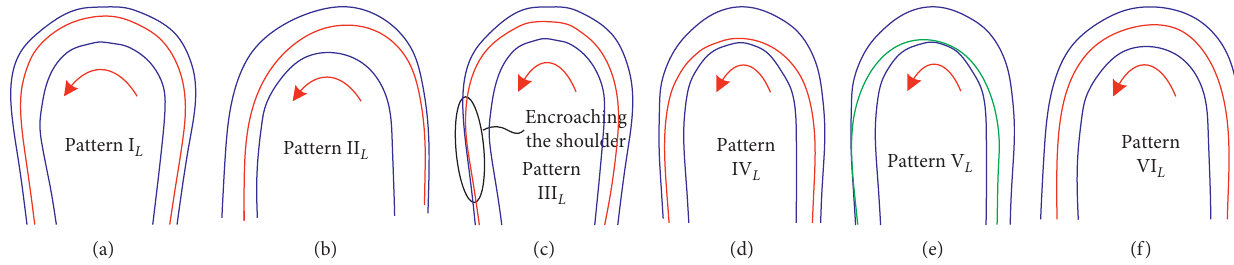
Figure 8: Track patterns at left-hand hairpin curves. (a) Pattern I L : traveling in the legal lane; (b) pattern II L : cutting a curve at the exit; (c) pattern III L : occupying the opposite lane at curve entrance and occupying the shoulder when leaving the turn; (d) pattern IV L : cutting a curve at the middle; (e) pattern V L : cutting curve at the entrance; (f) following the road centerline.